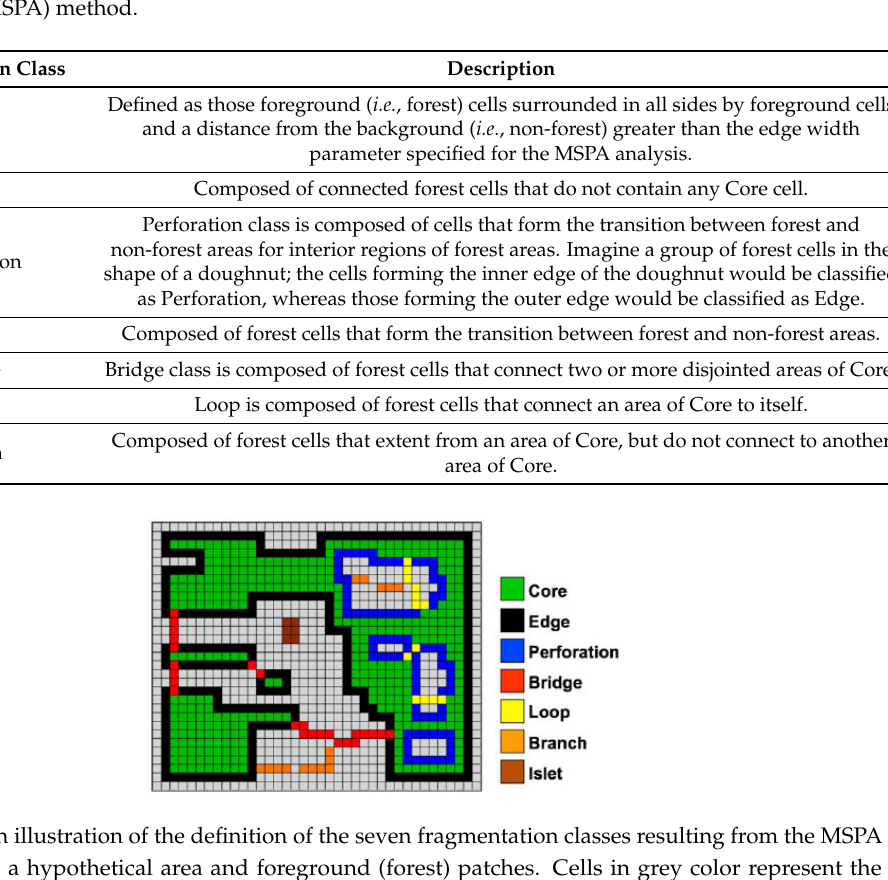
Table 1. Definition of the basic fragmentation classes created by the Morphological Spatial Pattern Analysis (MSPA) method.